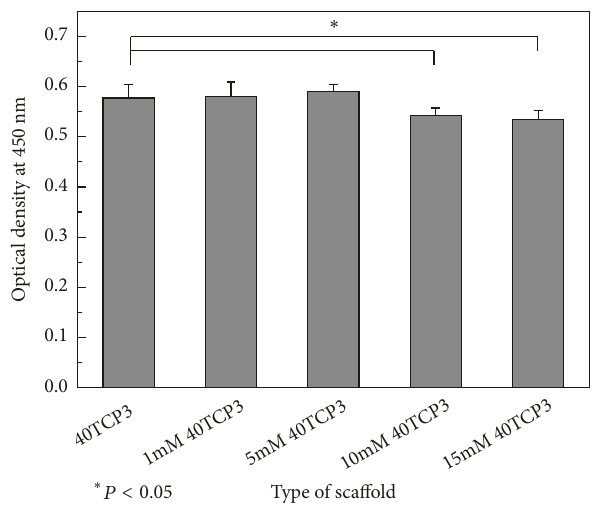
Figure 6: WST assay for viability of MC3T3-E1 at 5-day culture. Mean ± SD; 𝑛 = 4 . ∗ 𝑃 < 0.05 means significantly